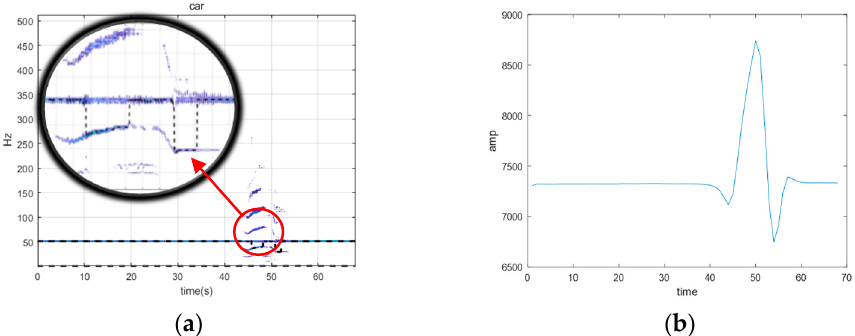
Figure 11. Extracting wavelet energy ridge and geomagnetic calibration. Among them, ( a ) is the time-frequency ridge image extracted on the basis of Figure 10c, and ( b ) is the interference caused by the object measured by the fluxgate sensor in the geomagnetic environment. The change time of the two is consistent, which means that our scheme effectively detects the power frequency magnetic anomaly signal caused by the target.